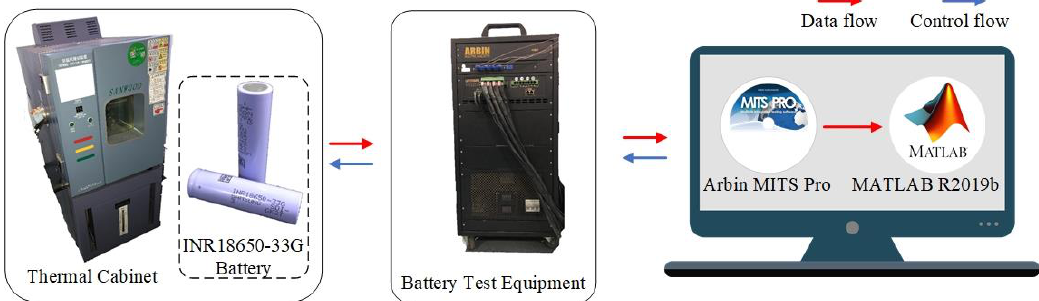
Figure 2. Outline of the test bench: offline calibration and schedule condition application.